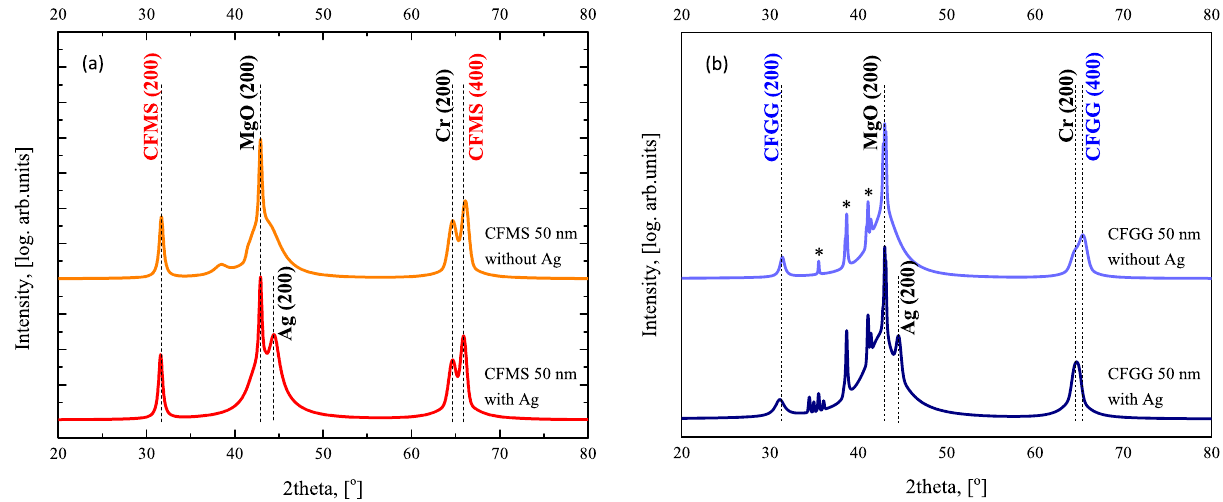
Figure 2. XRD scan patterns for CFMS ( a ) and CFGG ( b ) samples with 50-nm-thick magnetic layer and with/ without the Ag buffer layer; the peaks indicated by *originate from the MgO single crystal substrate.